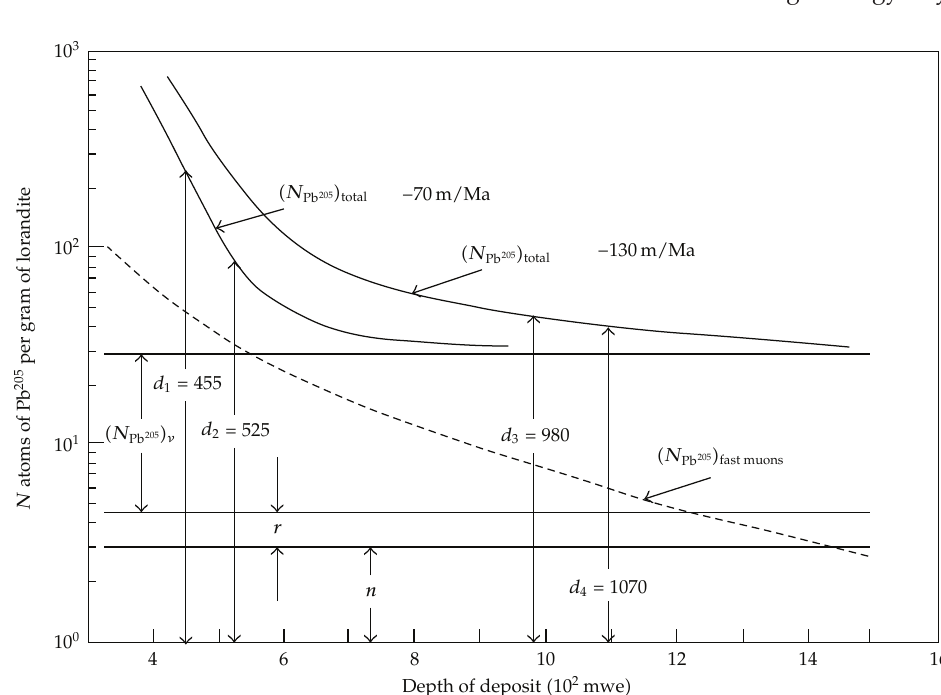
Figure 2: Estimate of the present amount of 205 Pb in lorandite due to solar neutrinos and to background reactions in the last 4 . 31 · 10 6 years as a function of the paleodepth d p of lorandite. The values are calculated by Pejovi´c by adopting the value of 0 . 55 μ b for the neutrino capture cross-section for 205 Tl from Hartman et al. (cid:6) 9 (cid:7) , the contents of U and Th in lorandite and surrounding rocks are from Pavi´cevi´c (cid:6) 6 (cid:7) and the method of Heisinger et al. (cid:6) 7 (cid:7) . n : contributions due to lead mobilized from the rock walls. r